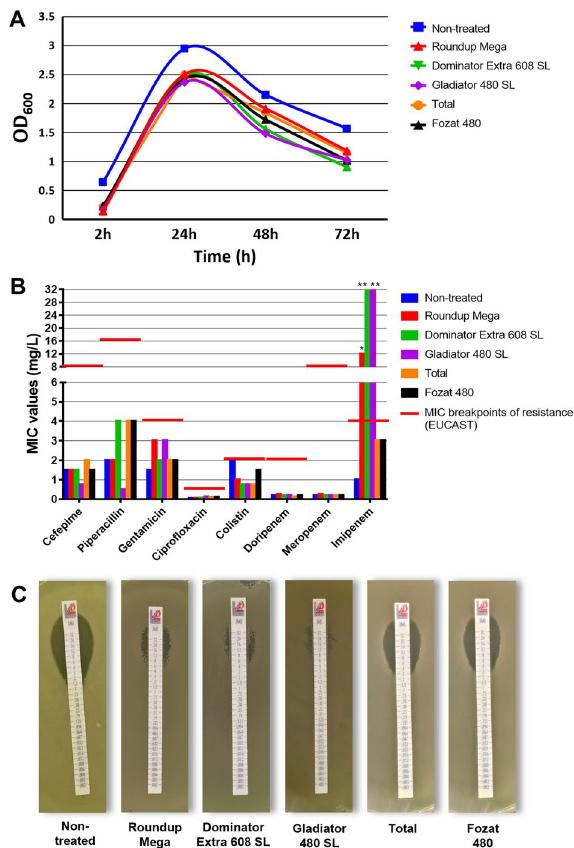
Figure 1. Preliminary liquid broth assay of P. aeruginosa HF234 with 0.5% (v/v) GBH pre-exposure (averaged values of three technical replicates). ( A ) Optical density (OD 600 ) of broth cultures during the 72 h pre-exposure with GBHs. ( B ) MIC values of HF234 cultures after 72 h of pre-exposure with GBHs, plated on GBHs-free agar plates. ( C ) Inhibition zones of HF234 cultures after 72 h of pre-exposure with GBHs, plated on GBHs-free agar plates. *,**Significantly different from the non-treated strain (p =